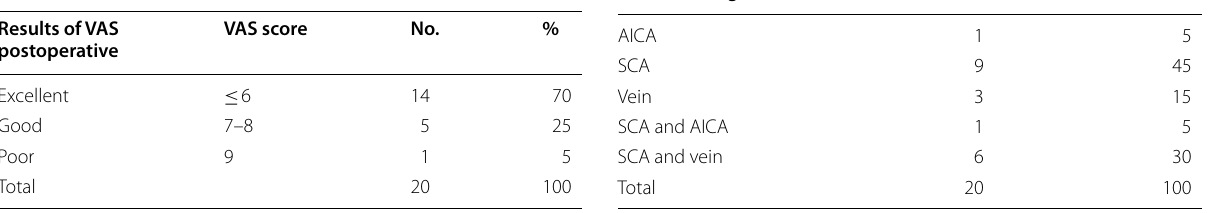
Table 2 Immediate postoperative results after microvascular decompression